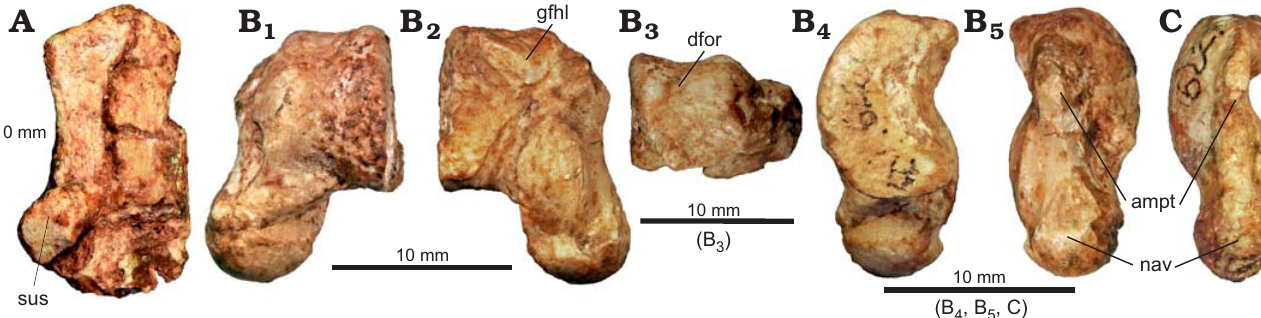
Fig. 3. Tarsal bones of typotherian notoungulate Colbertia lumbrerense Bond, 1981 (PVL 6227) from Pampa Grande, Salta Province, Argentina, Lower Lumbrera Formation, middle Eocene (Vacan subage of the Casamayoran SALMA). A . Left dorsoplantarly compressed calcaneum in dorsal view. B . Left astragalus in dorsal (B 1 ), plantar (B 2 ), posterior (B 3 ), lateral (B 4 ), and medial (B 5 ) views. C . Right dorsoplantarly compressed astragalus in medial view. Abbreviations: ampt, astragalar medial plantar tuberosity; dfor, dorsal astragalar foramen; gfhl, groove for the tendon of the flexor hallucis longus muscle; nav, navicular facet; sus, sustentacular